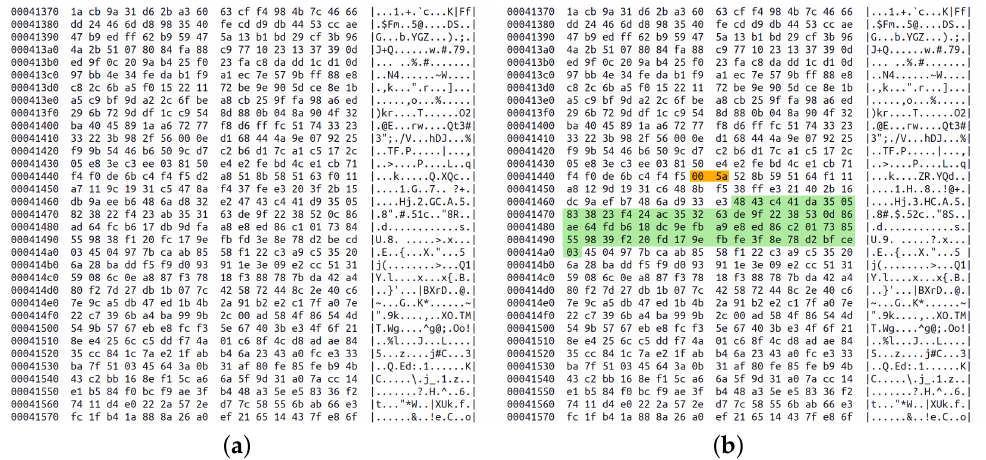
Figure 10. Videostego method: ( a ) carrier before embedding; ( b ) carrier after embedding, two orange bytes encode the length, green bytes contain secret data in their least significant bits.